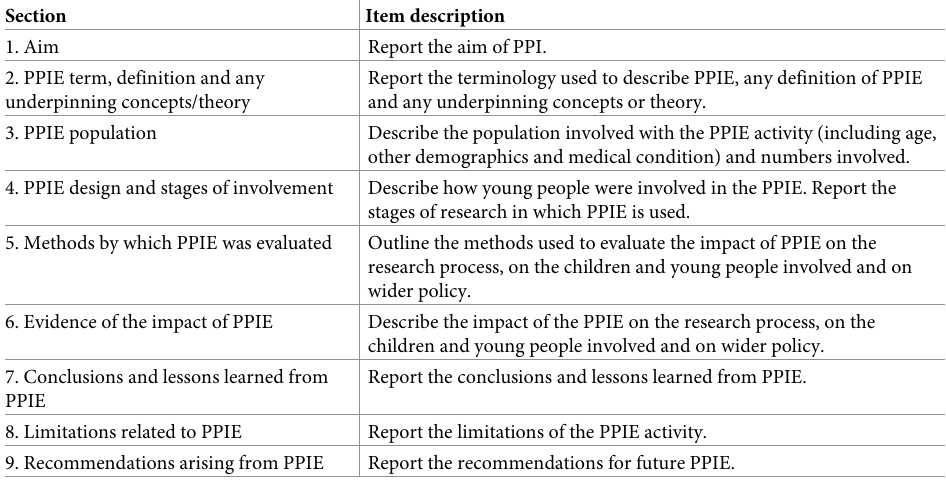
Table 2. Overview of data extraction items based on adapted Guidance for Reporting Involvement of Patients and the Public 2 (GRIPP2) form [27]. Section Item